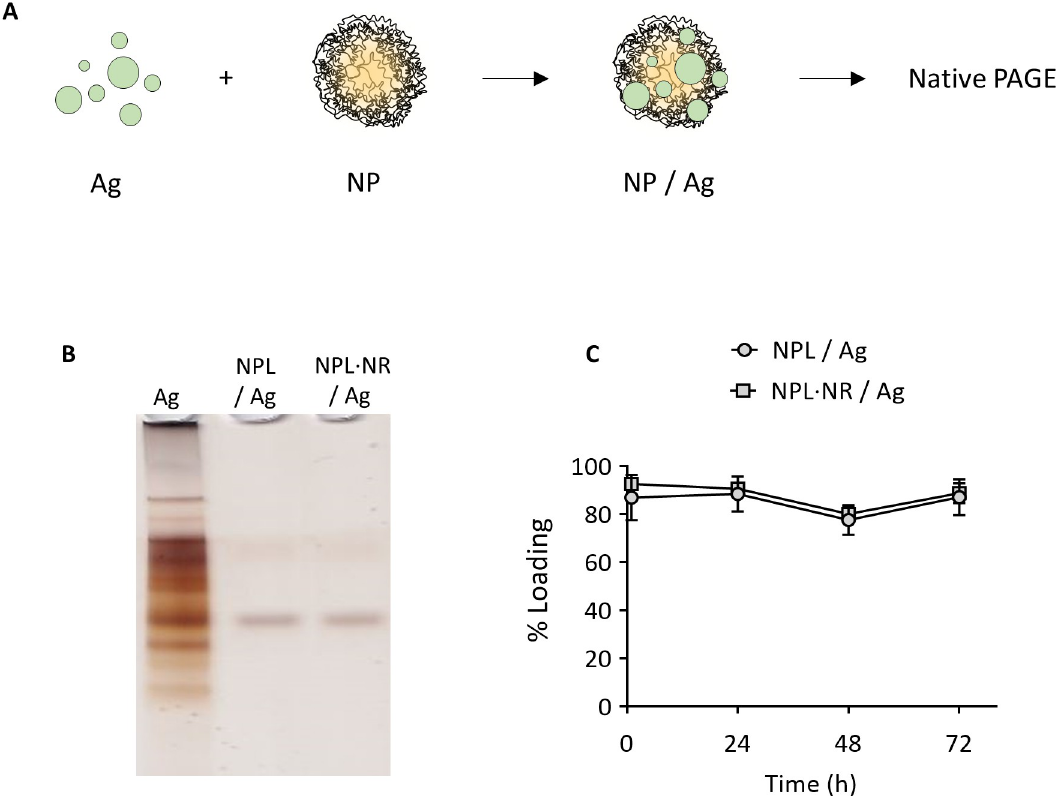
Fig 5. A: Schematical representation of the NPs/Ag formulations. B: Native PAGE of NPs/Ag (30% weight ratio) after 1h; C: Loading stability of the NPs/Ag (30% weight ratio) for 3 days.